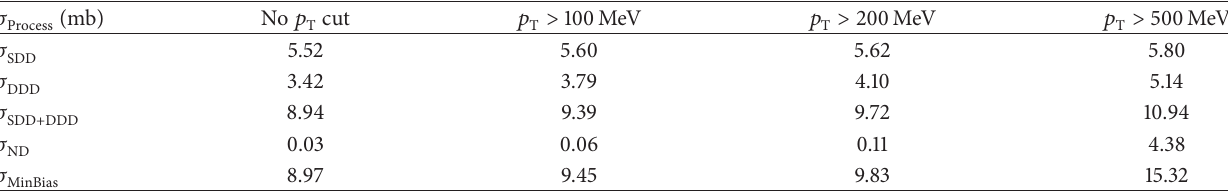
Table 3: Visible cross sections for different cuts on the transverse momentum of the final state particles in |𝜂| < 5.2 for Δ𝜂 > 3 cut. Gap is defined as edge gap.